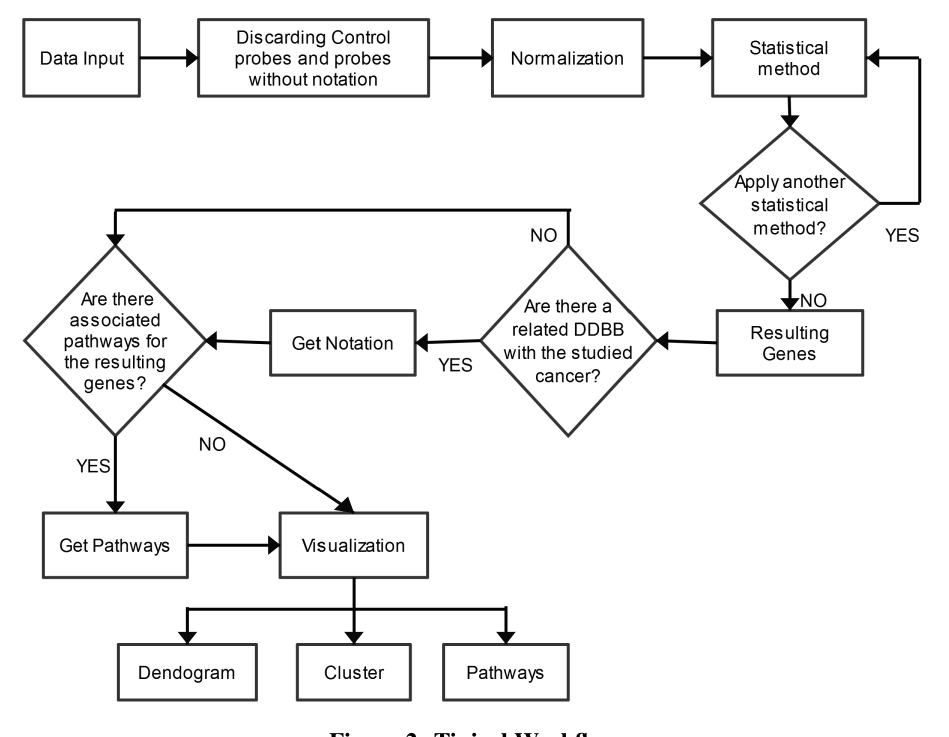
Figure 2: Tipical